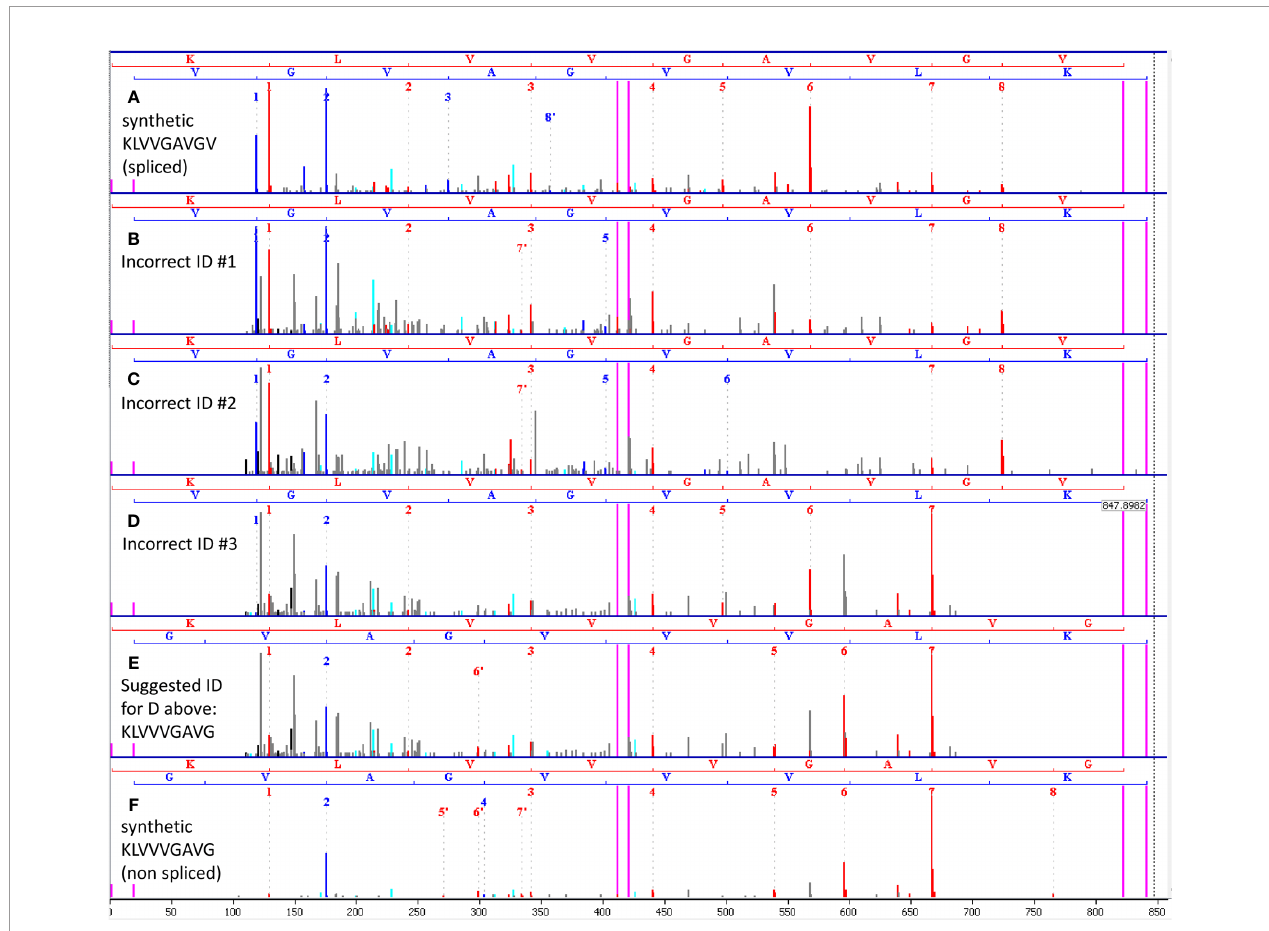
FIGURE 1 | (A) Spectrum of synthetic KLVVGAVGV, obtained from the authors ’ data. This synthetic peptide represents the proteasome-spliced peptide claimed to have been found by the authors by MS. (B – D) Three representatives of the multiple spectra identi fi ed by the authors as the spliced peptide KLVVGAVGV in the fi rst 45 runs. Each of the other spectra is similar to one of these representatives. None of the spectra looks like the synthetic spectrum in (A) . Hence, we may conclude that the spliced peptide KLVVGAVGV was not present in the 45 runs. (E) Our suggested alternative identi fi cation of the spectrum in (D) as KLVVVGAVG, a non- spliced peptide. (F) Spectrum of synthetic KLVVVGAVG con fi rms the alternative identi fi cation in (E) . The spectra in (B, C) were found in time 0, and hence cannot be proteasome products. In (A – F) red peaks are b-ions, blue peaks are y-ions and violet vertical lines mark parent/precursor masses and b/y ladder